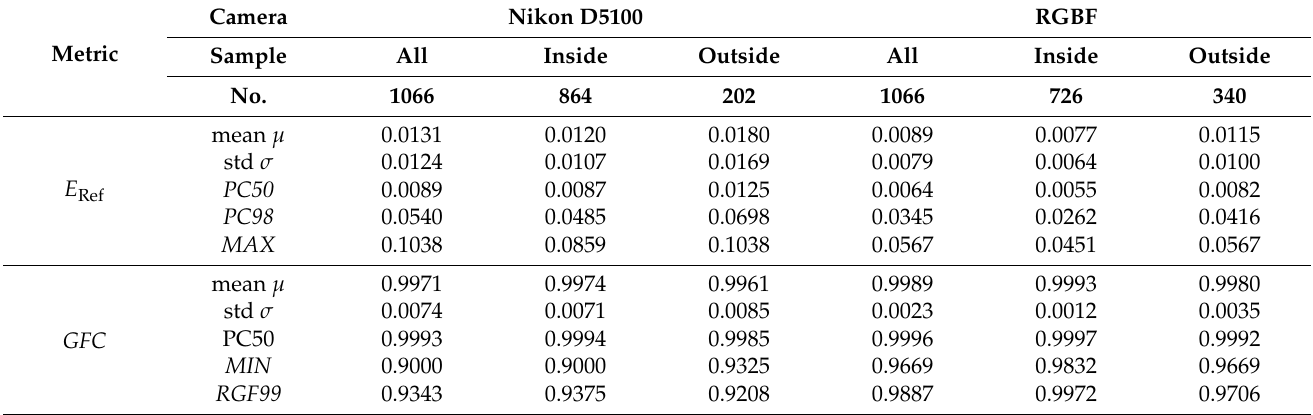
Table 1. Assessment metric statistics for the spectrum reconstruction of test samples using the D5100 and RGBF cameras. The spectrum reconstruction method is the LUT